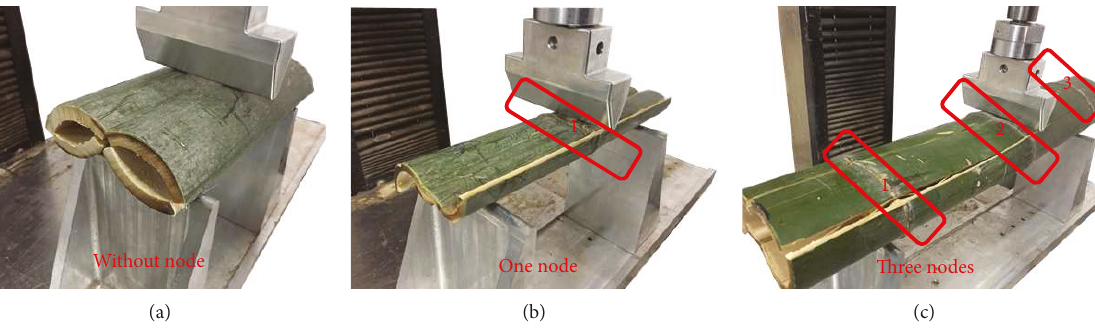
Figure 4: Bending test process: (a) without node, (b) one node, and (c) three nodes.